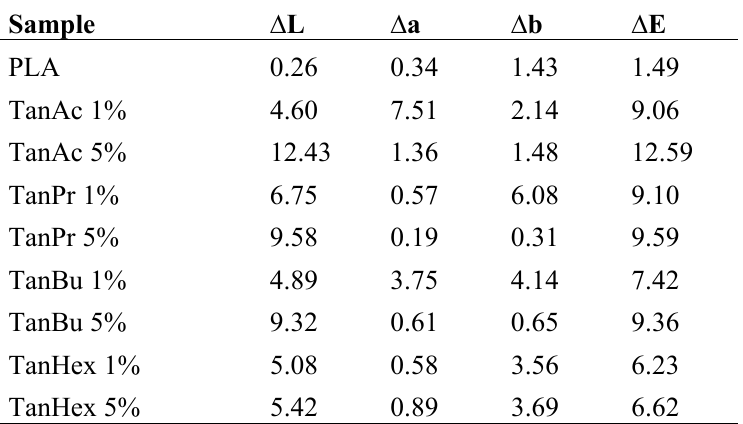
Table 5. Results of colorimetric analysis after artificial weathering